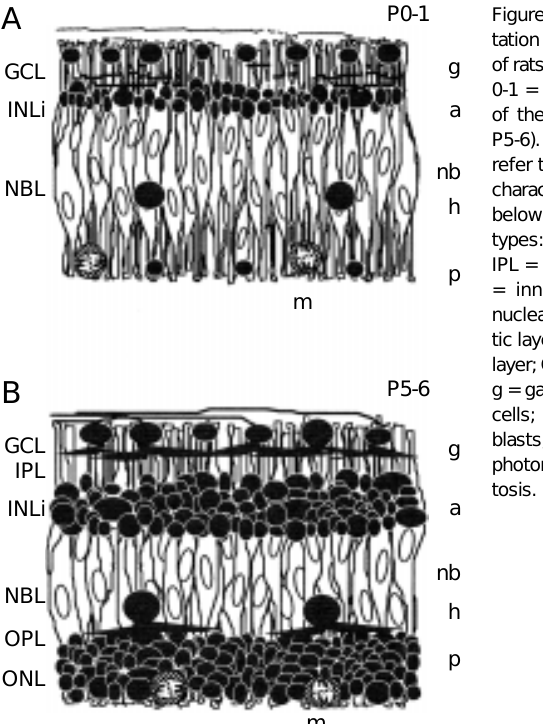
Figure 1 - Schematic represen- tation of the developing retina of rats at birth (A, postnatal days 0-1 = P0-1) or towards the end of the first postnatal week (B, P5-6). Abbreviations on the left refer to the retinal layers, while characters on the right side and below each drawing refer to cell types: GCL = ganglion cell layer; IPL = inner plexiform layer; INLi = inner portion of the inner nuclear layer; NBL = neuroblas- tic layer; OPL = outer plexiform layer; ONL = outer nuclear layer; g = ganglion cells; a = amacrine cells; nb = proliferating neuro- blasts; h = horizontal cells; p